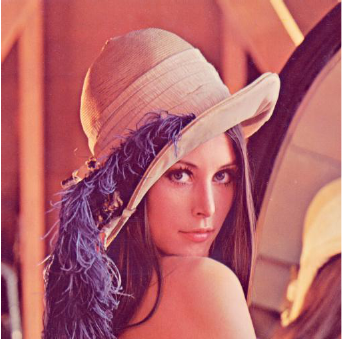
Fig. 1. Original image